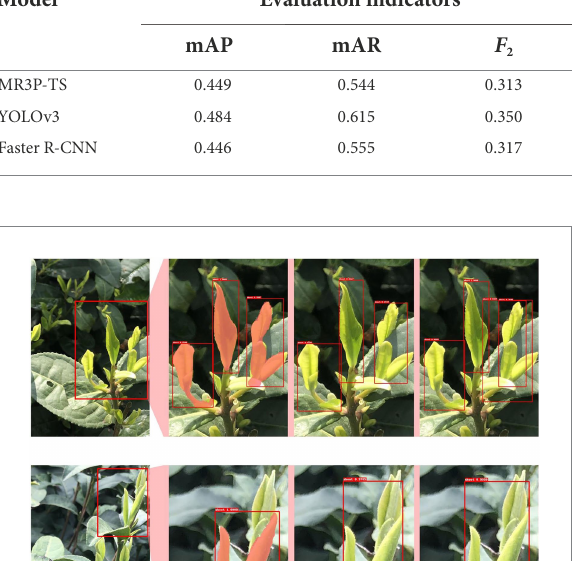
TABLE 3 Recognition results of several models. Model